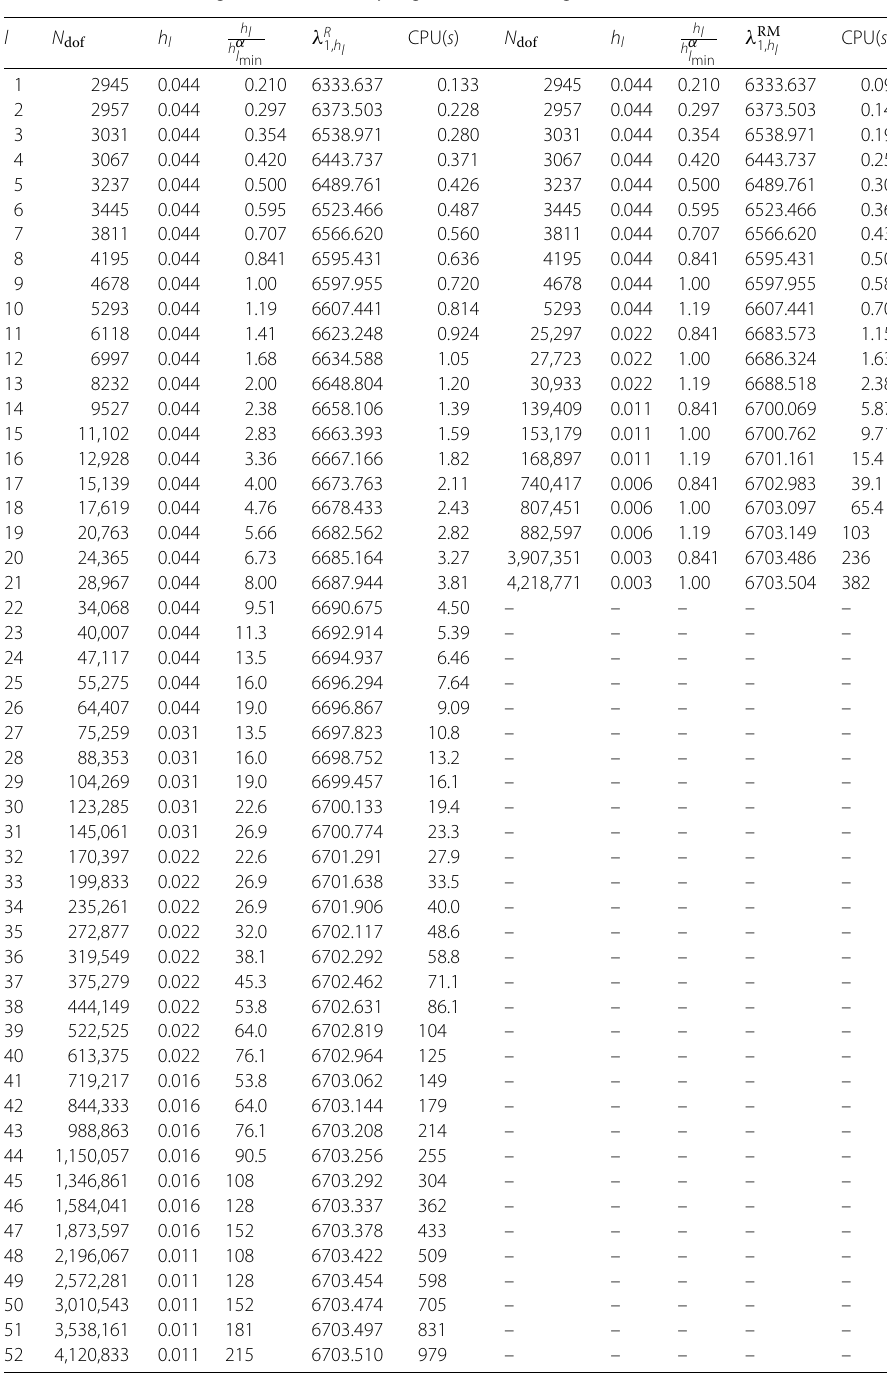
Table 2 The smallest eigenvalue solved by Algorithm 2 and Algorithm